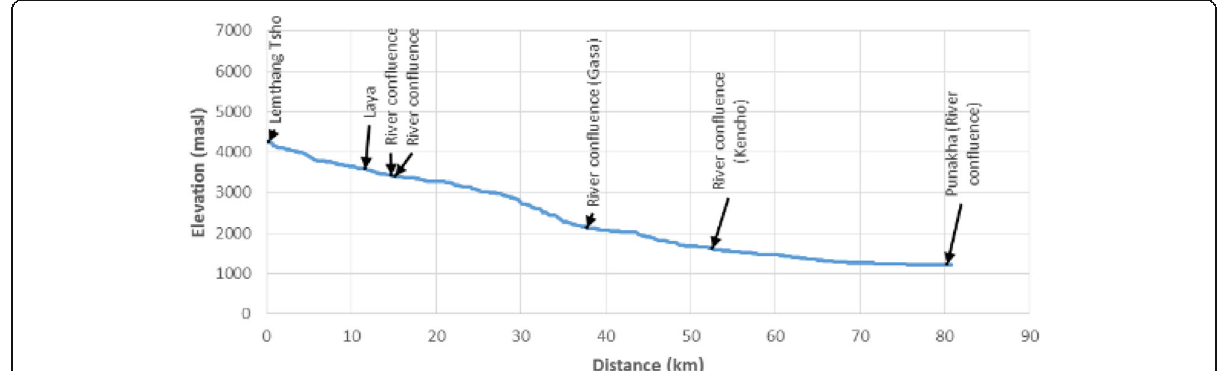
Fig. 8 Longitudinal profile of Mo Chu downstream from Lemthang Tsho to Punakha Dzong